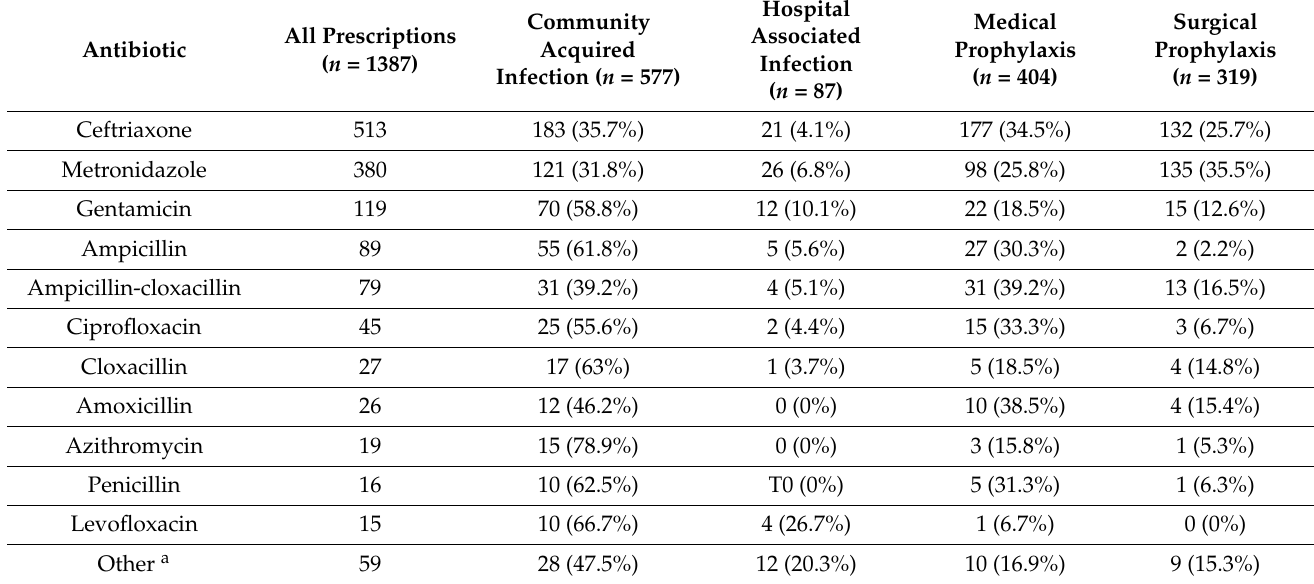
Table 2. Prevalence of antibiotic use by